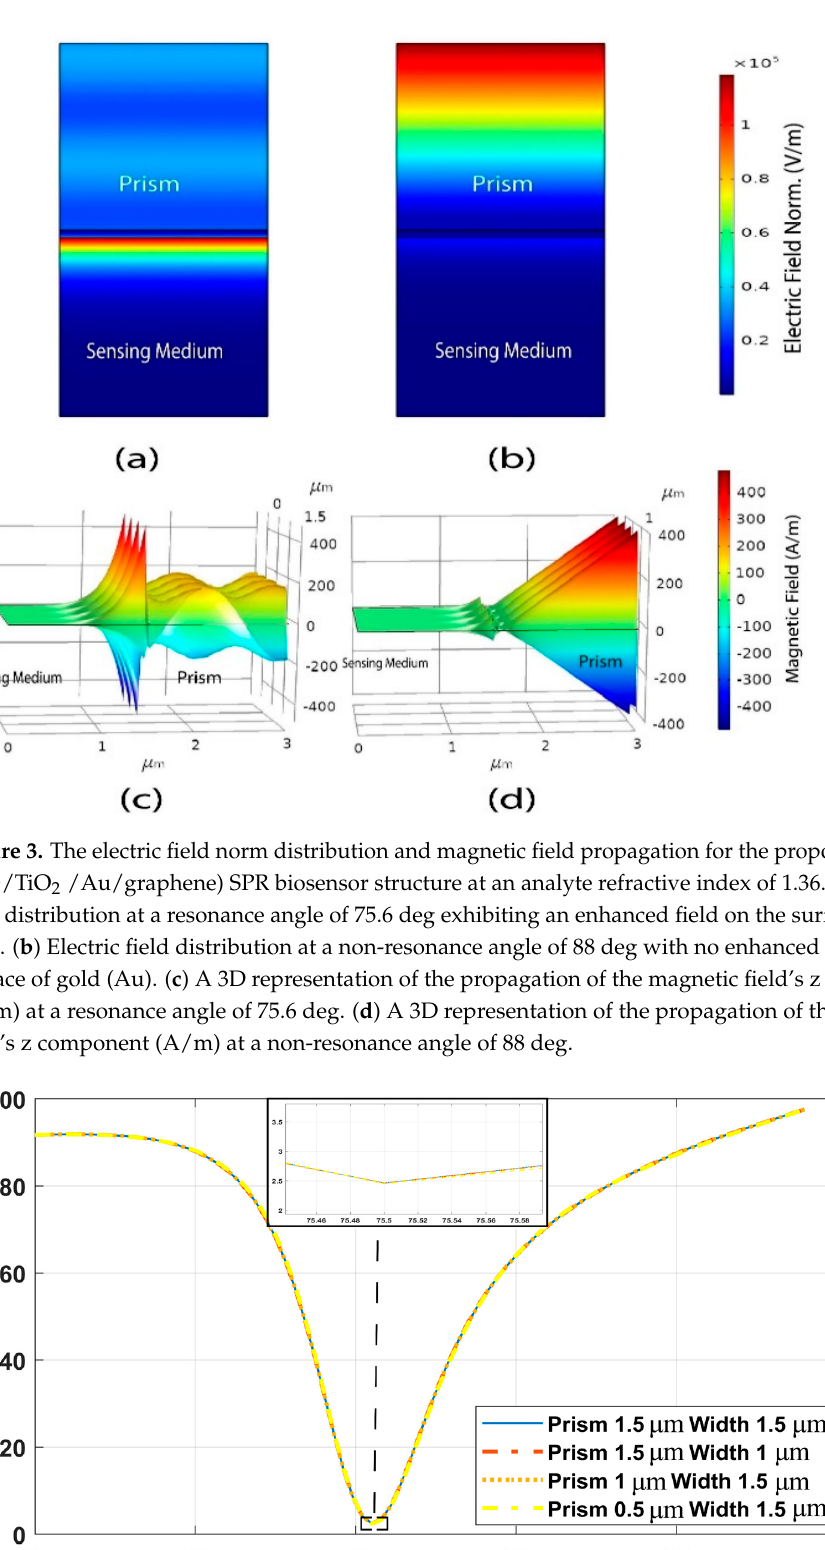
Figure 2. General COMSOL Multiphysics view structure of the proposed (BK (cid:2875) /TiO (cid:2870) /Au/graphene) SPR biosensor. ( a ) Computational meshing domain. ( b ) Numerical simulation model of the pro- posed structure.